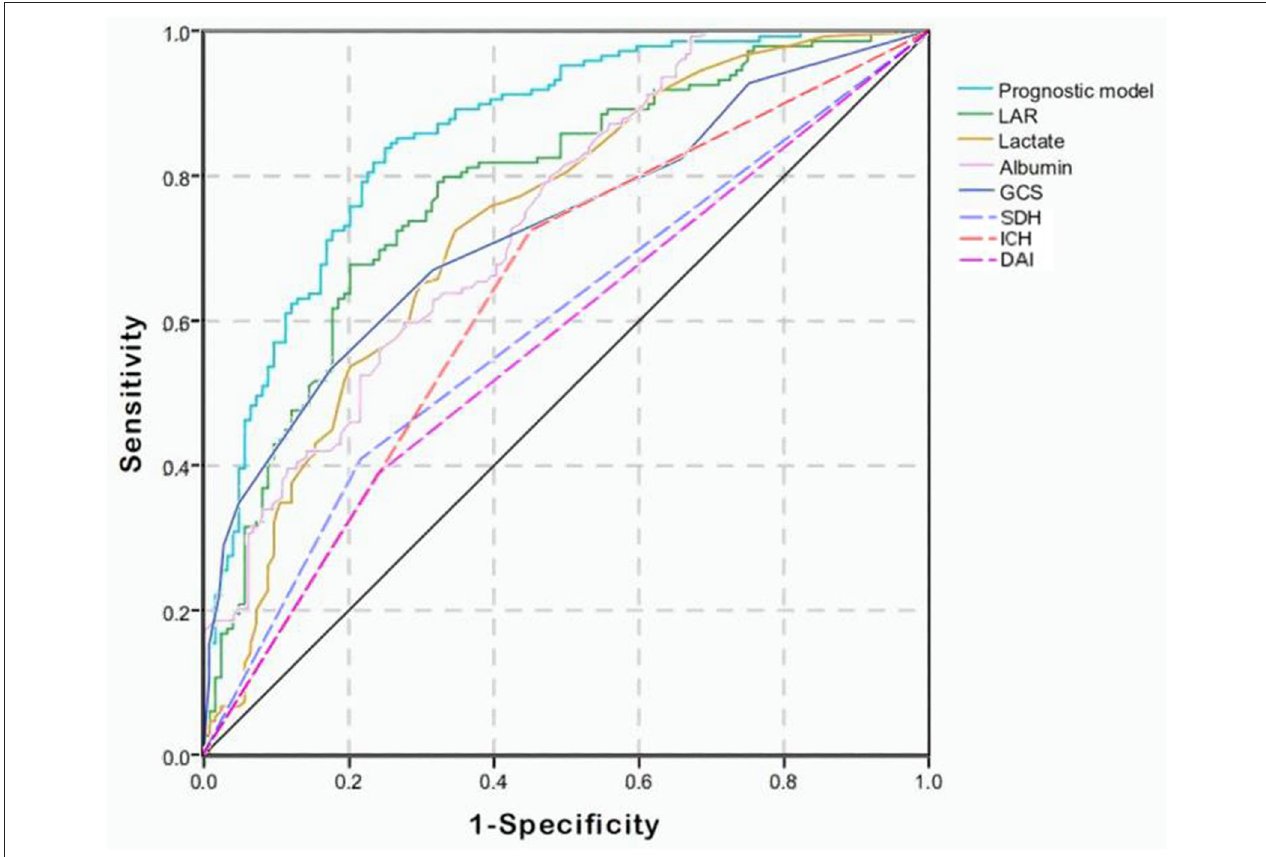
FIGURE 1 | Receiver operating characteristic (ROC) curves of predictive factors and the prognostic model for predicting mortality in moderate to severe TBI patients. The area under the curve (AUC) of GCS, lactate, albumin, LAR, SDH, IPH, and DAI and the constructed prognostic model was 0.729, 0.733, 0.740, 0.780, 0.596, 0.637, 0.574, and 0.857,